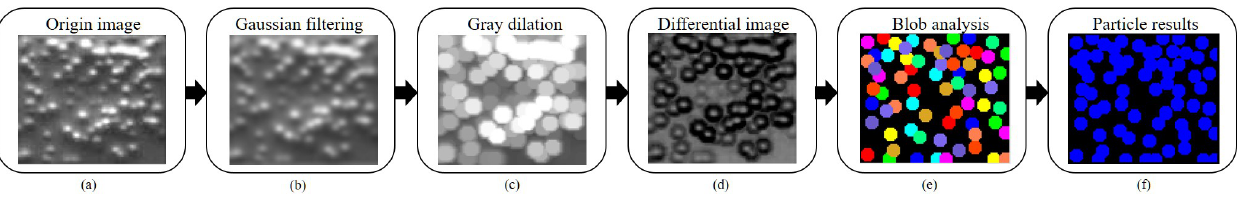
Figure 11. This flowchart shows the procedure of particle detection. The original image ( a ) is smoothed to image ( b ), ( b ) is dilated by a structuring element to produce ( c ), ( d ) highlights the particle centers, ( e ) remove noisy objects by features of the particle, and the final result is presented in ( f ). The processing and visualization of images are supported by